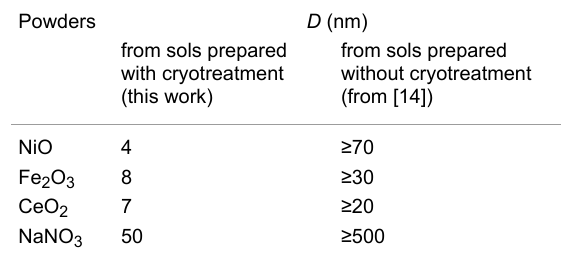
Table 1: The average diameter ( D ) of the crystallites of the obtained powders (X-ray diffraction data).